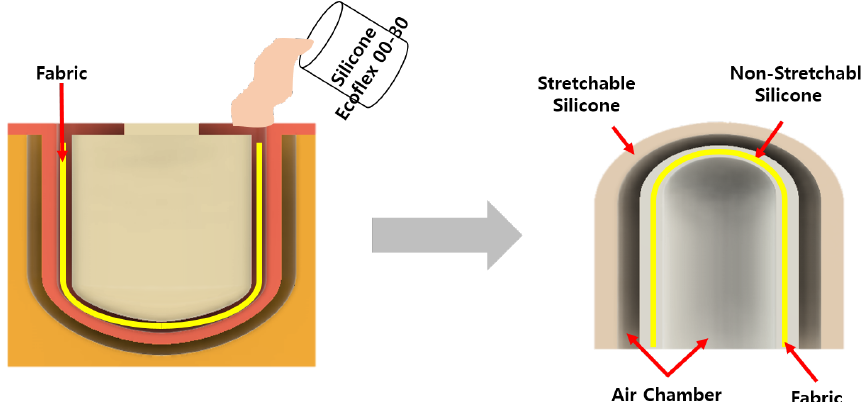
Figure 2. The haptic mouse fabrication process. ( left ) The 3D printed mold for casting the layers of the haptic mouse. ( right ) A conceptual design of the haptic mouse showing the stretchable and non-stretchable layers along with the air